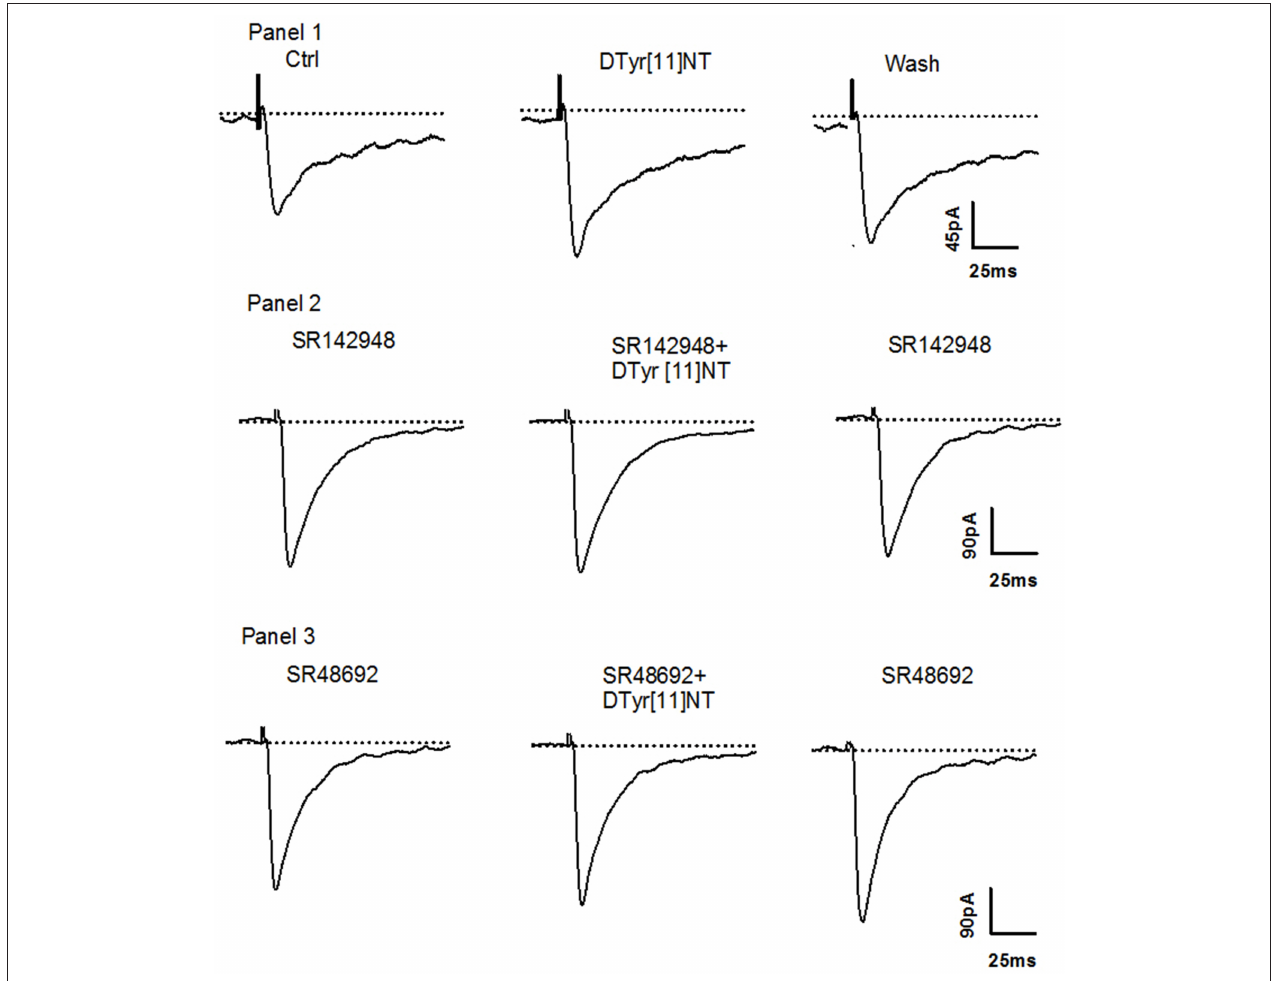
FIGURE 6 | Effect of [D-Tyr 11 ]NT and antagonists on I − h neurons. Panel 1: Current traces of glutamatergic EPSC recorded during superfusion of [D-Tyr 11 ]NT; control (1), with [D-Tyr 11 ]NT (0.01 µ M) (2) and following the washout of [D-Tyr 11 ]NT (3) at a holding membrane potential of − 70mV in I − h neurons ( n = 6 ). Panel 2: Current traces of glutamatergic EPSC recorded during superfusion with SR142948 (0.1 µ M) (1), with SR142948 and [D-Tyr 11 ]NT (0.01 µ M) (2) and with SR142948 following the washout of [D-Tyr 11 ]NT (3) at a holding membrane potential of − 70mV in I − h neurons ( n = 5 ). Panel 3: Current traces of glutamatergic EPSC recorded during superfusion with SR48692 (0.1 µ M) (1), with SR48692 and [D-Tyr 11 ]NT (0.01 µ M) (2) and with SR48692 following the washout of [D-Tyr 11 ]NT (3) at a holding membrane potential of − 70mV in I − h neurons ( n = 5